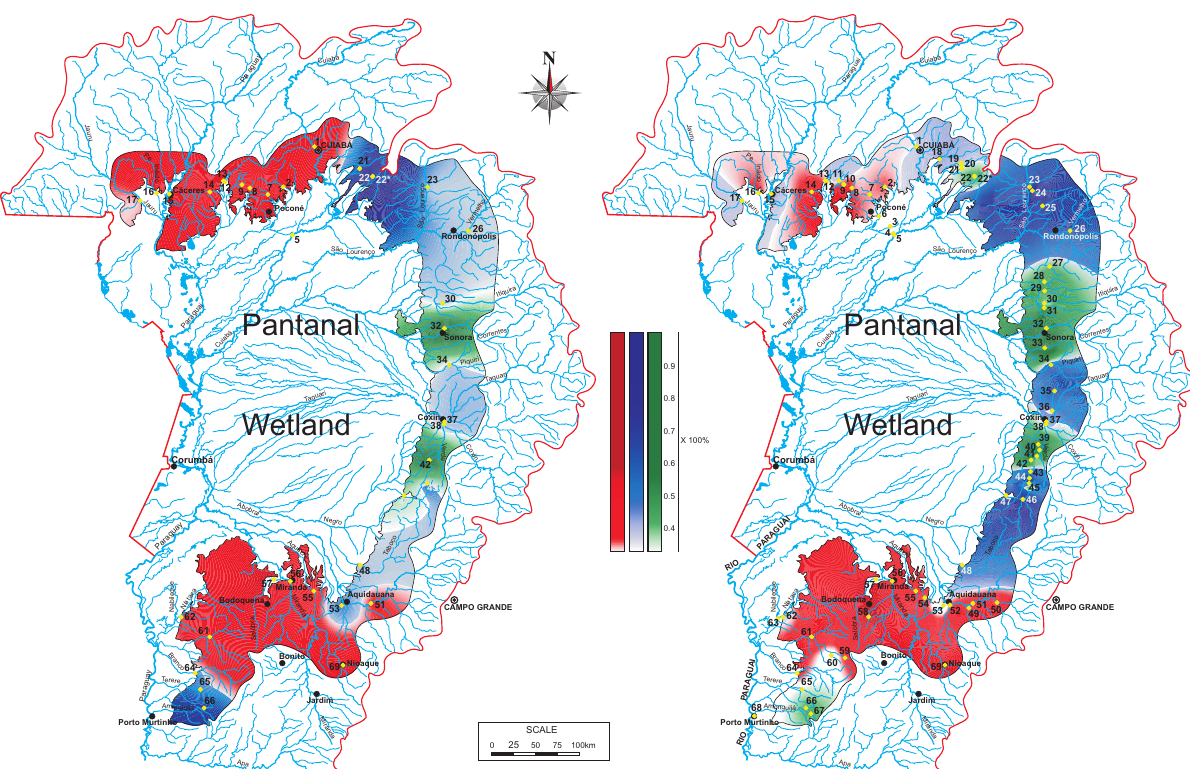
Fig. 9. Chemistry of river water at the border of the Pantanal wetland during DS 2008 (a) and WS 2010 (b) , deducted from PCA-based EMMA procedure (green: end-member 1, blue: end-member 2, red: end-member 3; contributions above 35% are drawn).